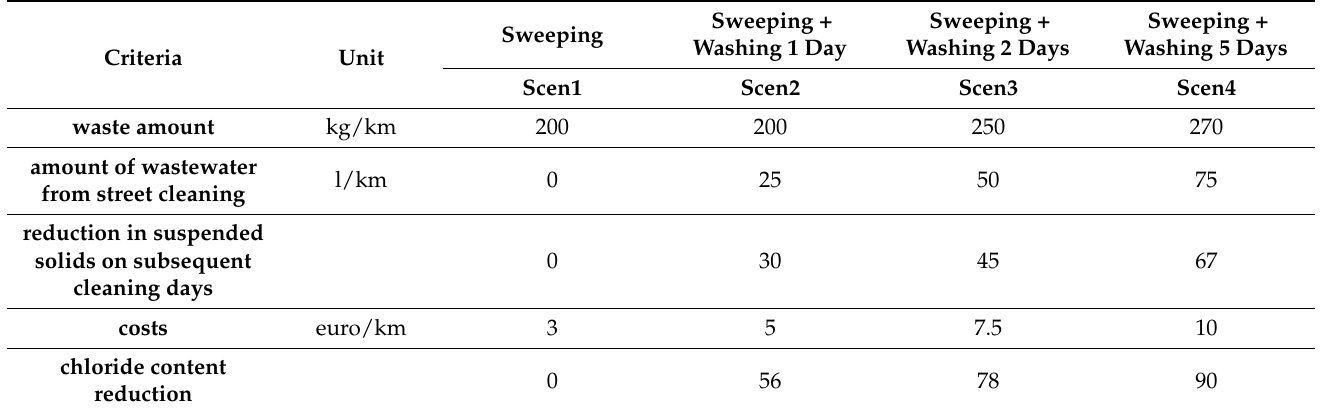
Table 2. Decision matrix for evaluating the adopted scenarios for the system of chloride removal from the